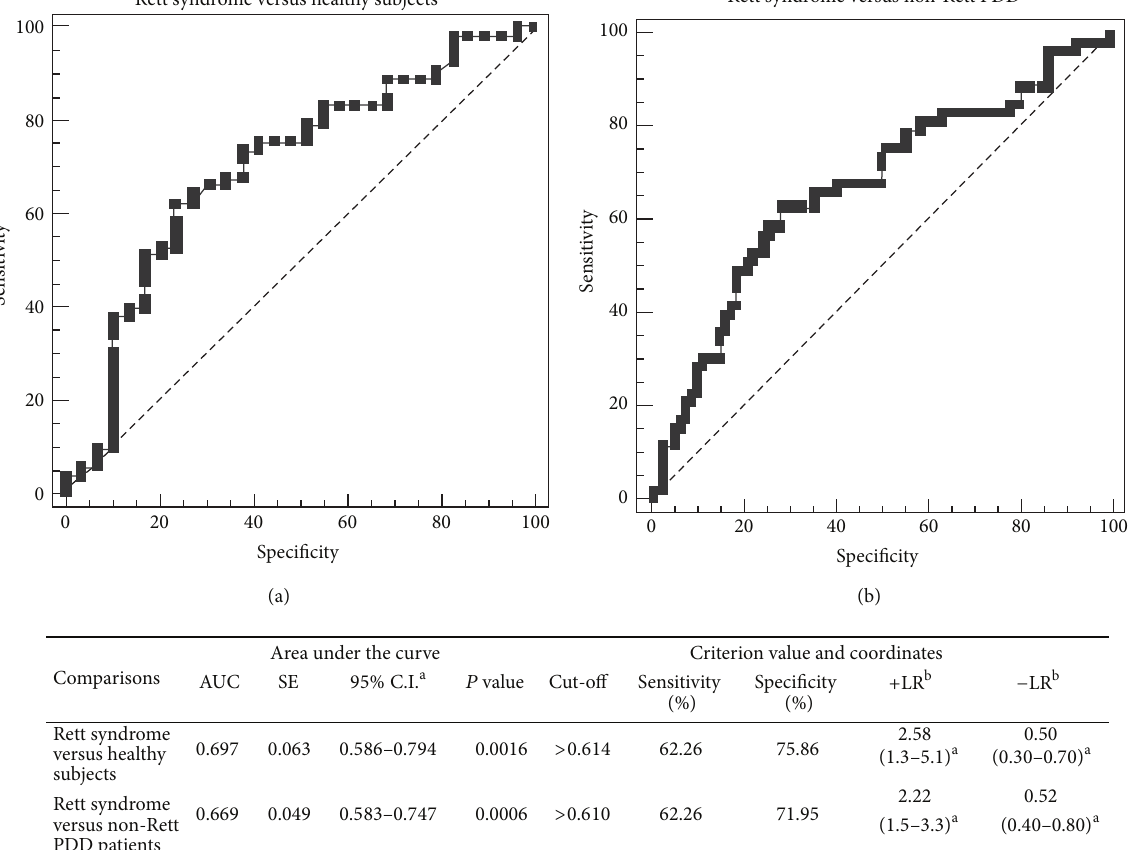
Figure 3: Receiver operating characteristic (ROC) analysis for anti-CSF114(Glc) serum IgM antibody titer. ROC curve discriminates RTT patients versus healthy subjects (a) and RTT patients from non-RTT PDD patients (b). Abbreviations list: AUC: area under the curve; SE: standard error; C.I: confidence intervals; L.R.: likelihood ratio. a 95% confidence interval; b likelihood